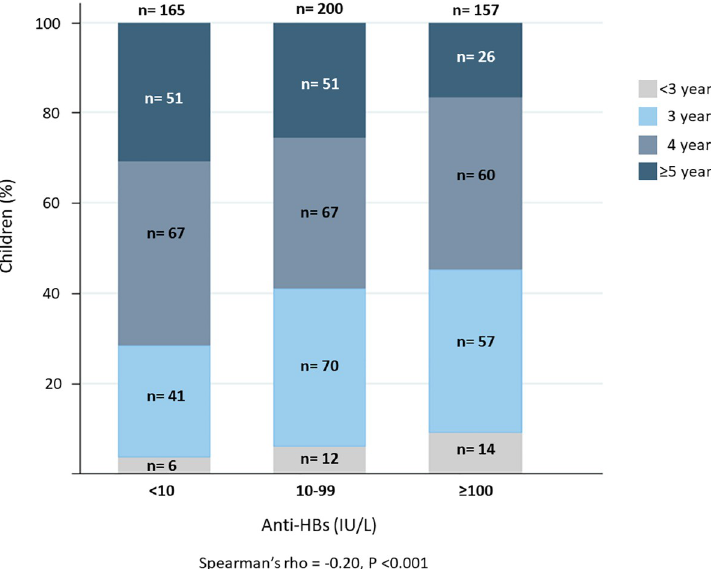
Fig 2. Anti-HBs titer categorized by age. Children were categorized by anti-HBs antibodies and age. Bar chart displaying number of children according to categories of anti-HBs ( < 10; 10–99; � 100 IU/L) across the age ( < 3; 3; 4; � 5